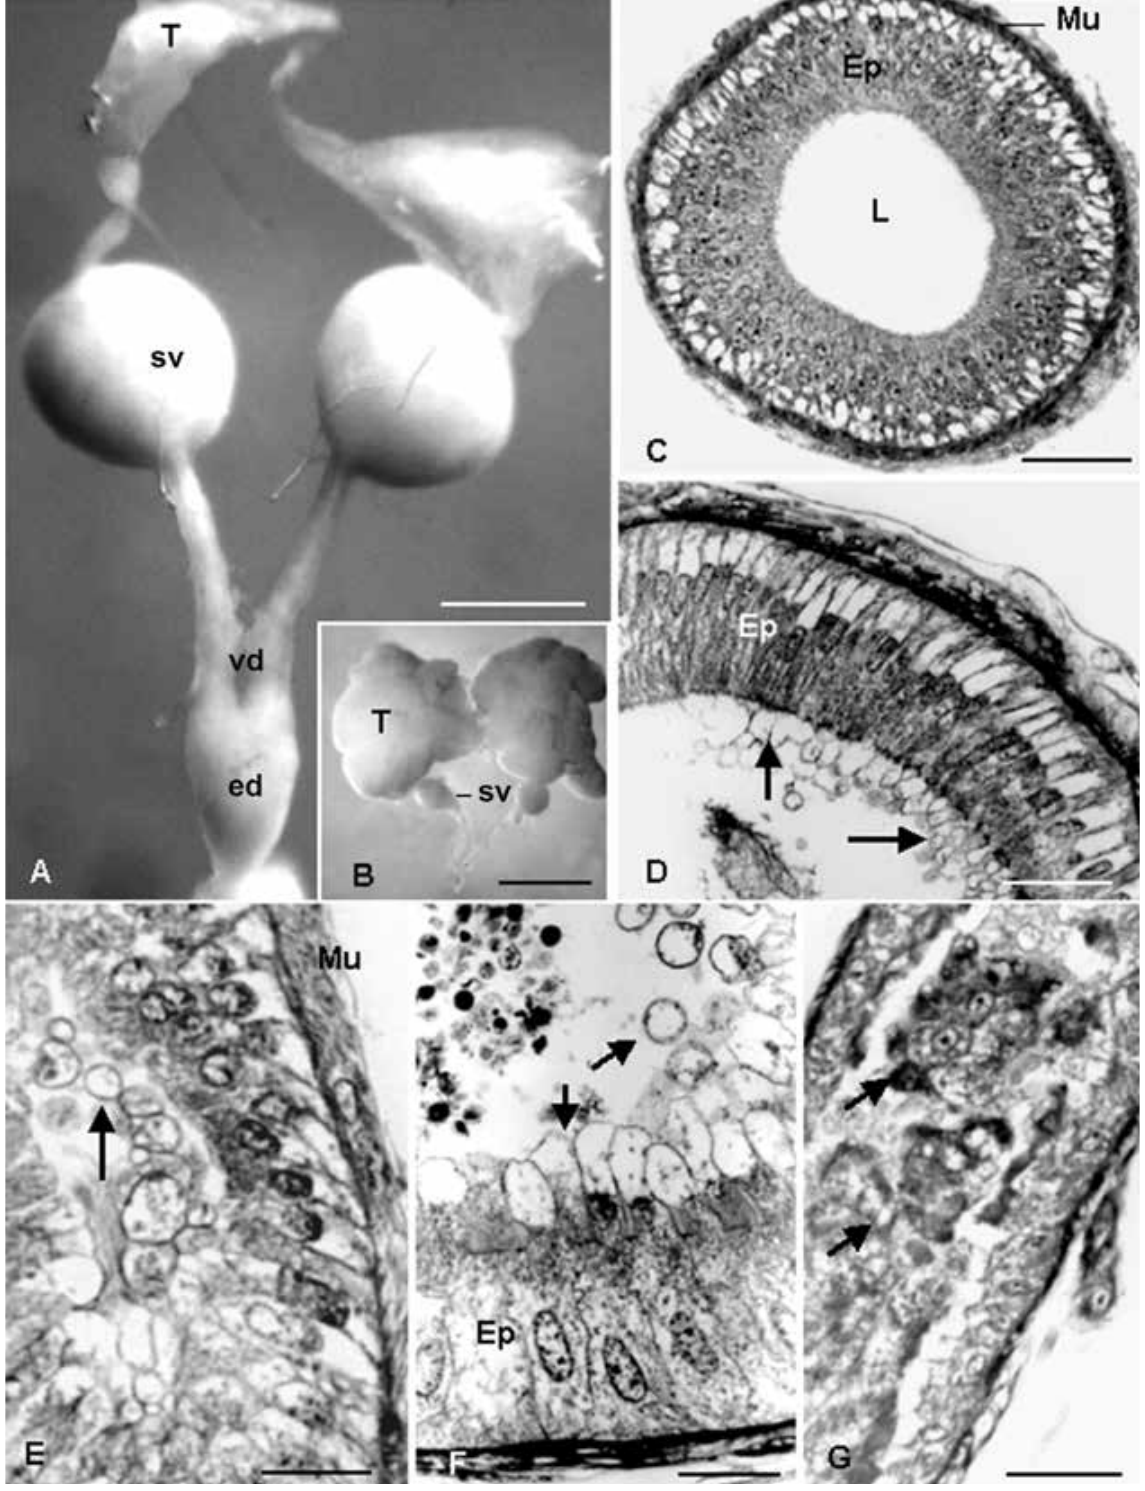
Fig 1. The male reproductive tract of Scaptotrigna xanthotricha . A. Sexually mature male 10-day-old showing degenerated testes (T), enlarged seminal vesicles (sv), vasa deferentia (vd) and the ejaculatory duct (ed). B. Black-eyed pupae showing well-developed testes (T) and dilated seminal vesicles (sv). C-D. Cross section of a seminal vesicle in pink-eyed pupae (C) and brown-eyed pupae (D) showing empty lumen (L), simple prismatic epithelium (Ep), vesicles (arrow), and a muscle layer (Mu). E-F. Cross section of vasa deferentia (E) and seminal vesicles (F) in black-eyed and non-pigmented body pupae showing the secretion in the lumen (arrows). G. Longitudinal section of a vas deferens in black-eyed and pigmented body pupae, showing the different secretions in the lumen (arrows). Bars: A-B = 0,7mm; C-G =